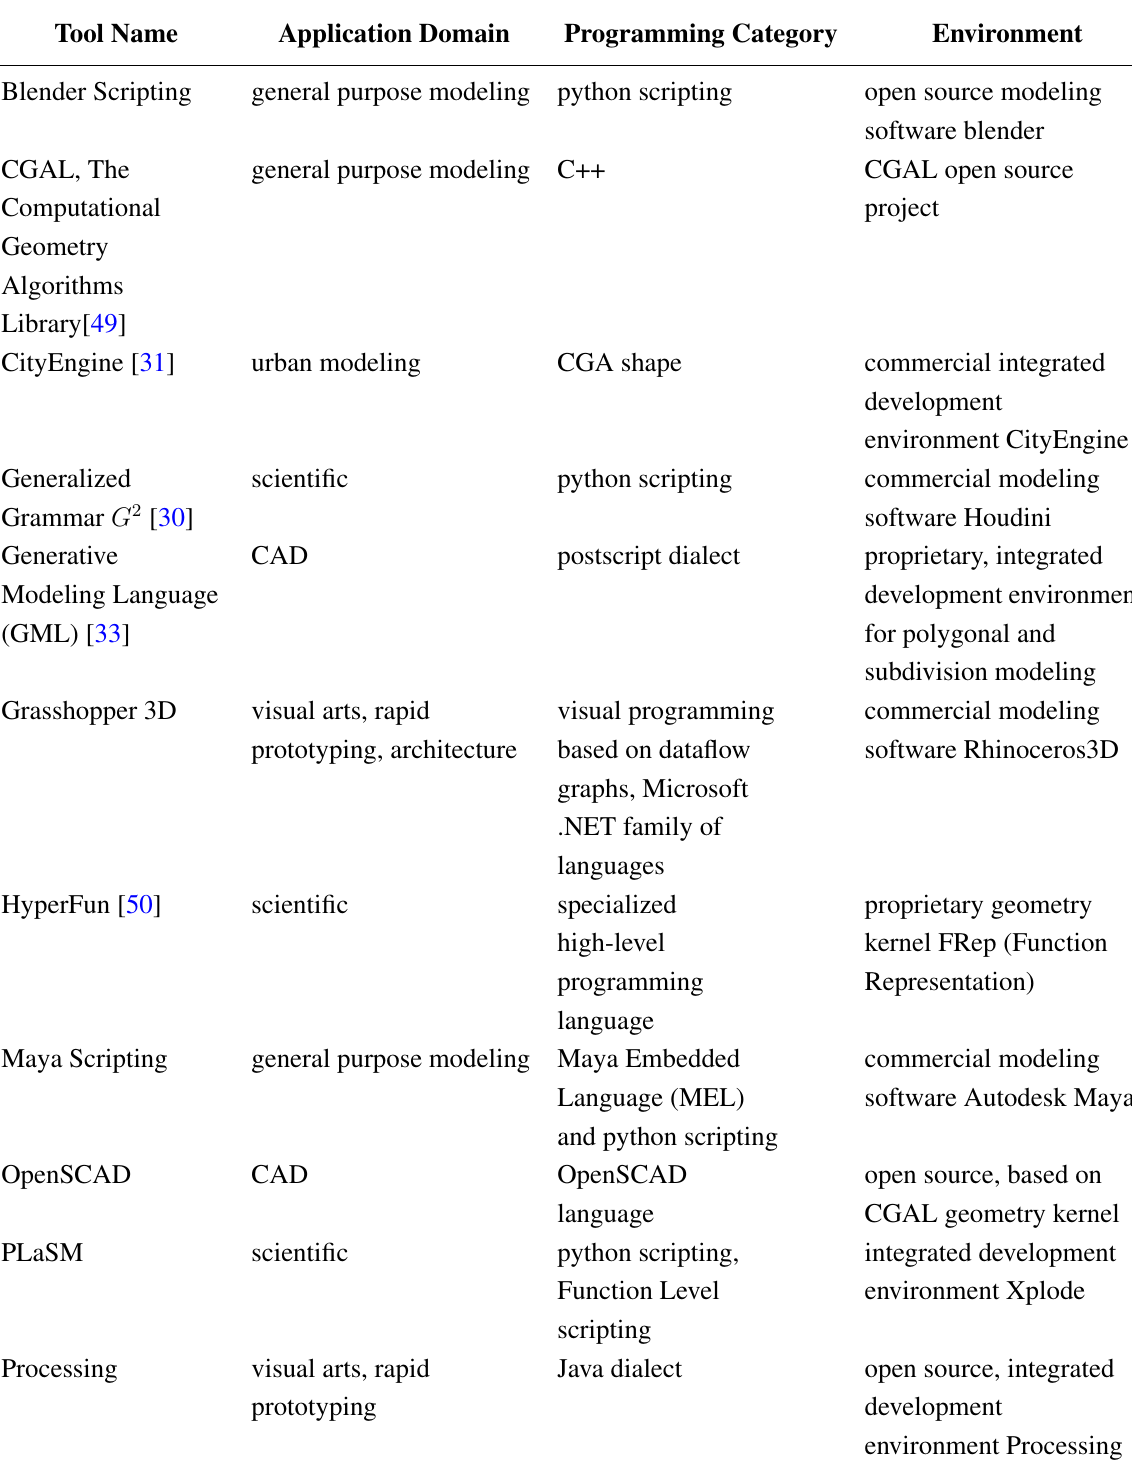
Table 1. Overview of generative/procedural 3D modeling tools and approaches (Part